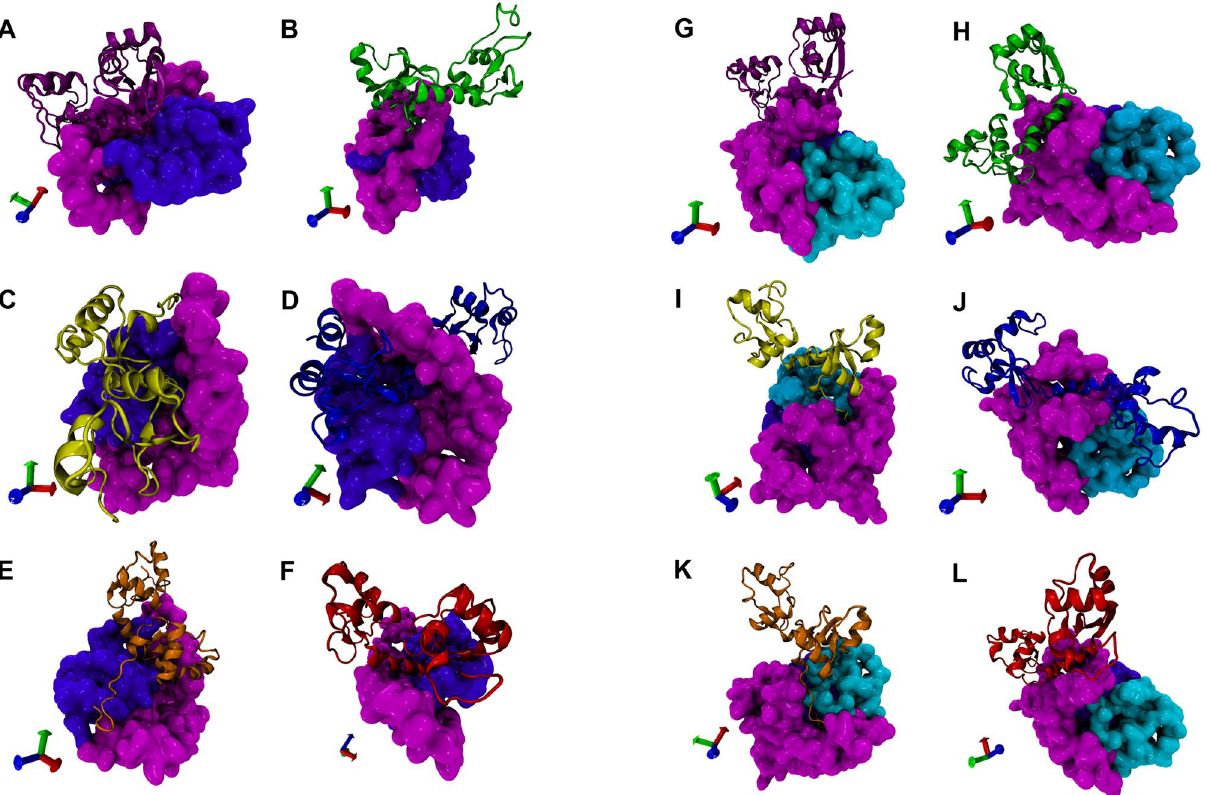
E-A176/G350 (blue), AAa (orange) and AAc (red) with MAGI-1 255 ( A – F ). Docking between MAGI-1 329 and E6-references and its variants ( G – L ) E6-reference (purple), E-G350 (green), C188/G350 (yellow), E-A176/ G350 (blue), AAa (orange) and AAc (red). MAGI-1 255 and MAGI-1 329 are represented in quicksurf in color magenta. The protein–protein docking was performed using the ClusPro 2.0 web